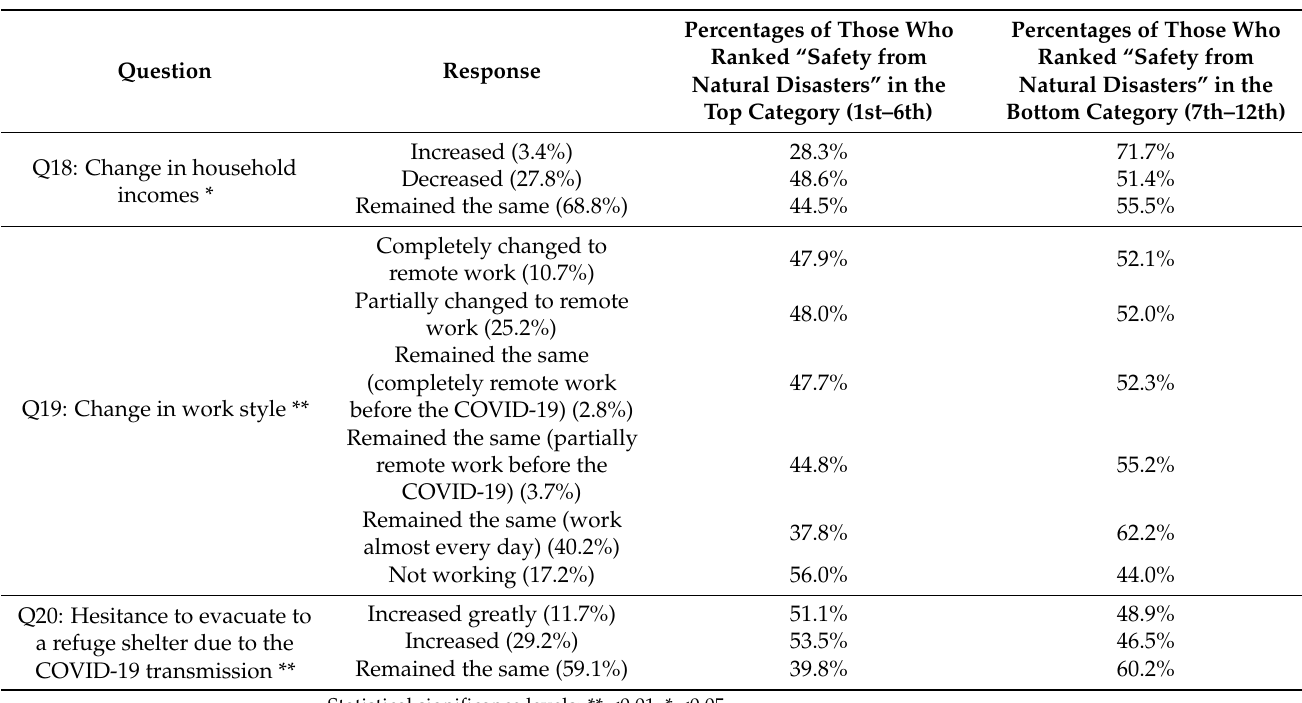
Table 4. Cross-tabulation results of the impacts of COVID-19 on respondents’ life and experiences and the relative preference of “safety from natural disasters” in residential choices ( n = 1554). The number in parentheses indicates the percentage of the item in each category.